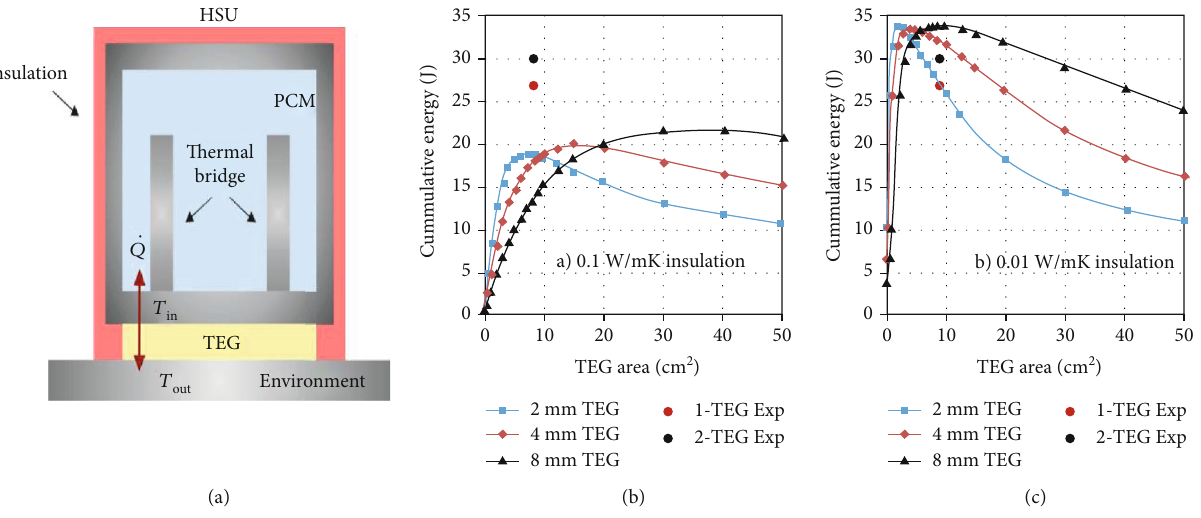
Figure 11: TEG design in dynamic TE energy harvesting (adapted from [9]).